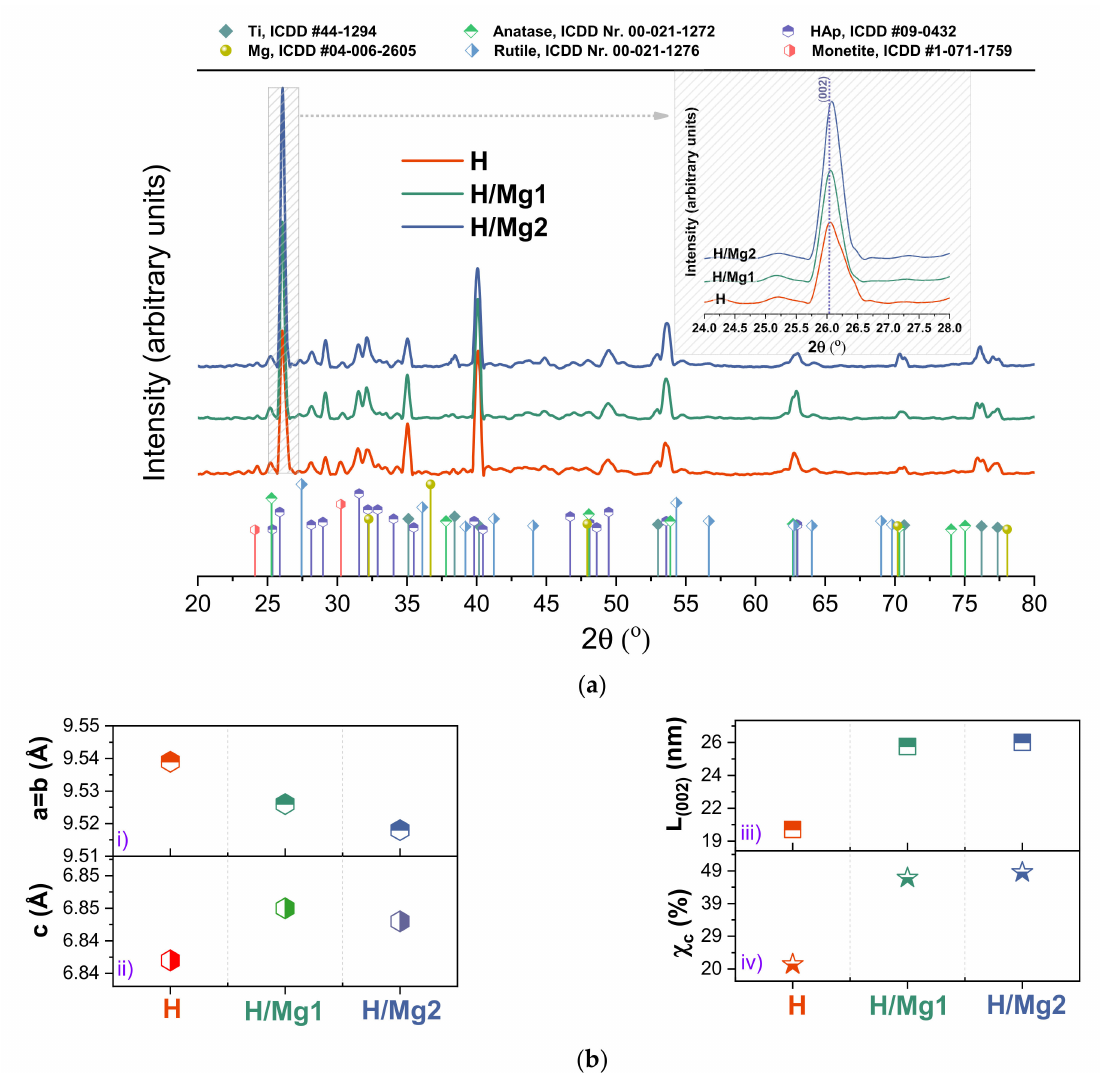
Figure 5. XRD diffractograms of the developed coatings ( a ) and evolution of the computed structural parameters ( b ): (i–ii)— a and c lattice parameters; (iii) crystallite dimension (L (002)), (iv)—crystallinity ( χ c